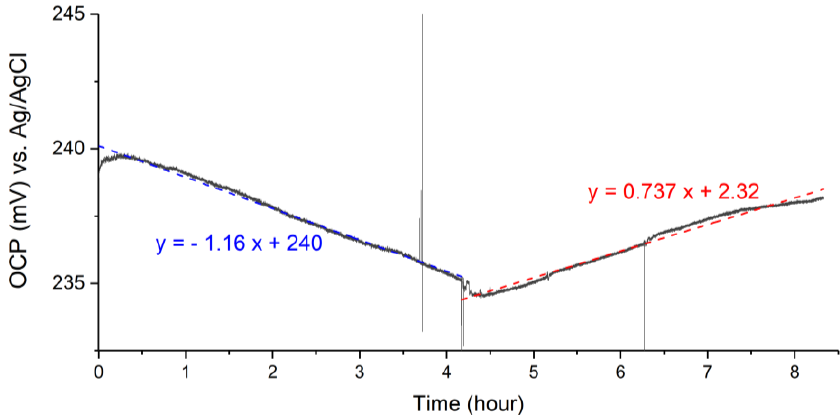
Figure 6. Open-circuit potential recording of wet-stored RuOx electrode, for the first 4 h in deaerated pH 7 buffer, followed by 4 h of reoxygenated pH 7 buffer. Fitted linearly by the dashed lines.